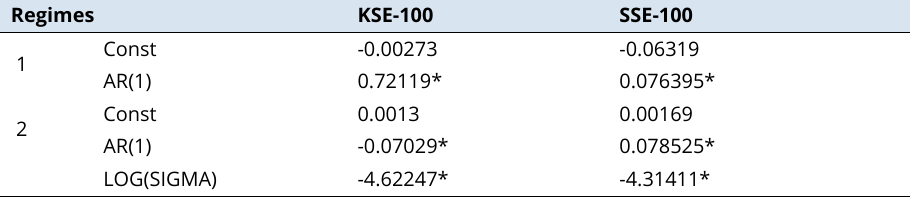
Results from Markov regime switching